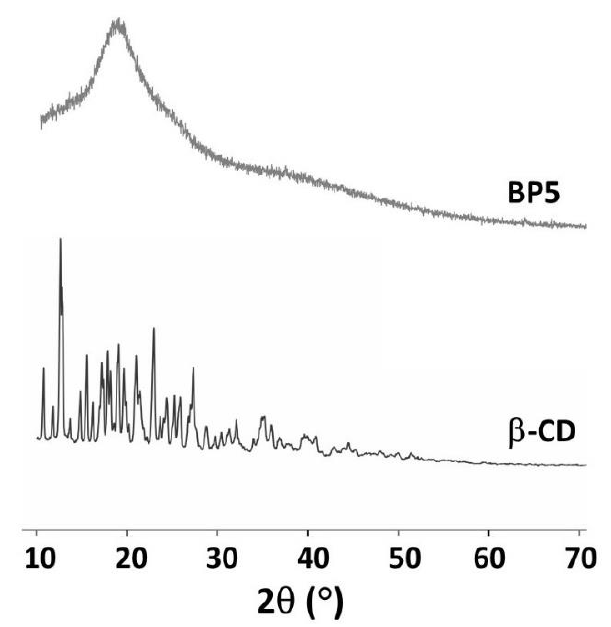
Figure 6. XRD spectra of β -CD and BP5 nanosponges.